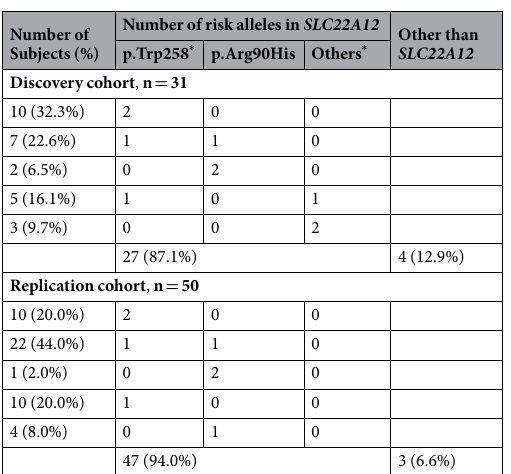
Number of risk alleles in SLC22A12